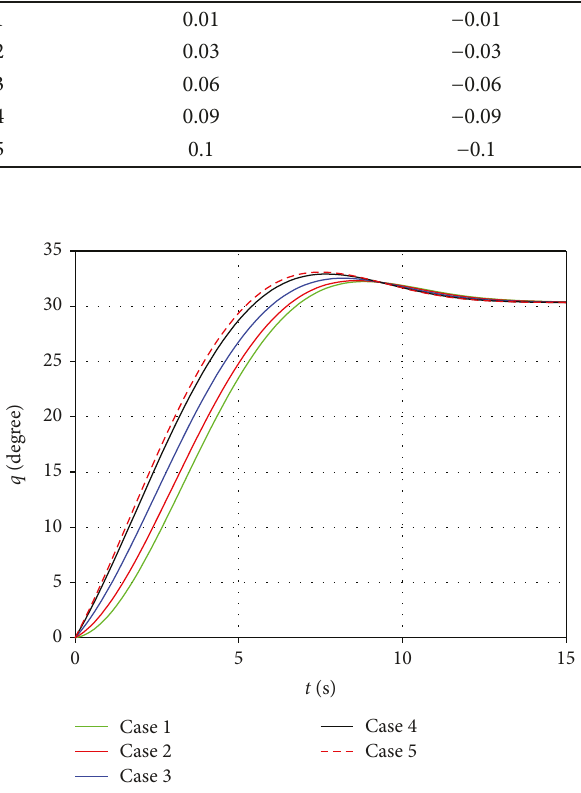
Figure 20: Intercept angle variation of Defender